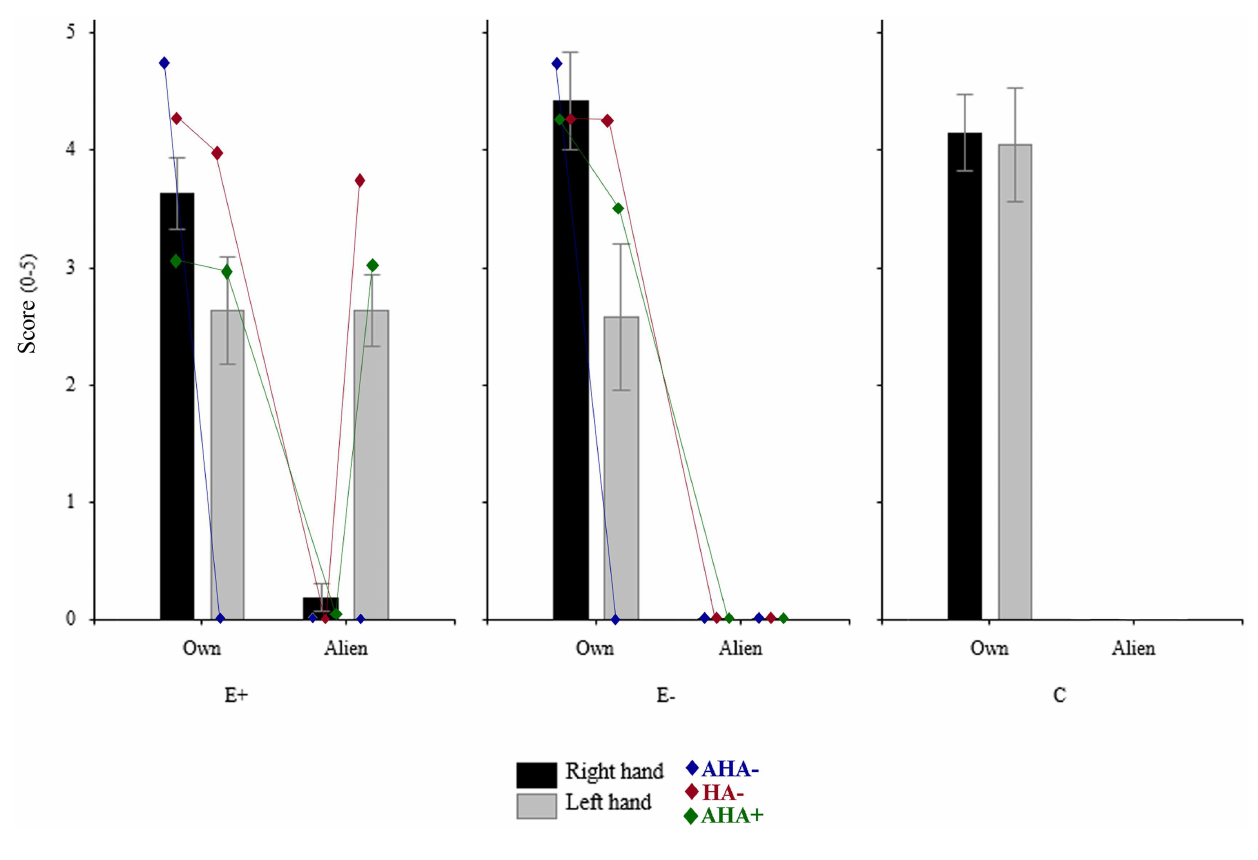
hemianesthesia without anosognosia; HA − , no loss; AHA + , anosognosia for hemianesthesia) are also plotted. * Significant ( p < 0.05); n.s., not significant ( p >